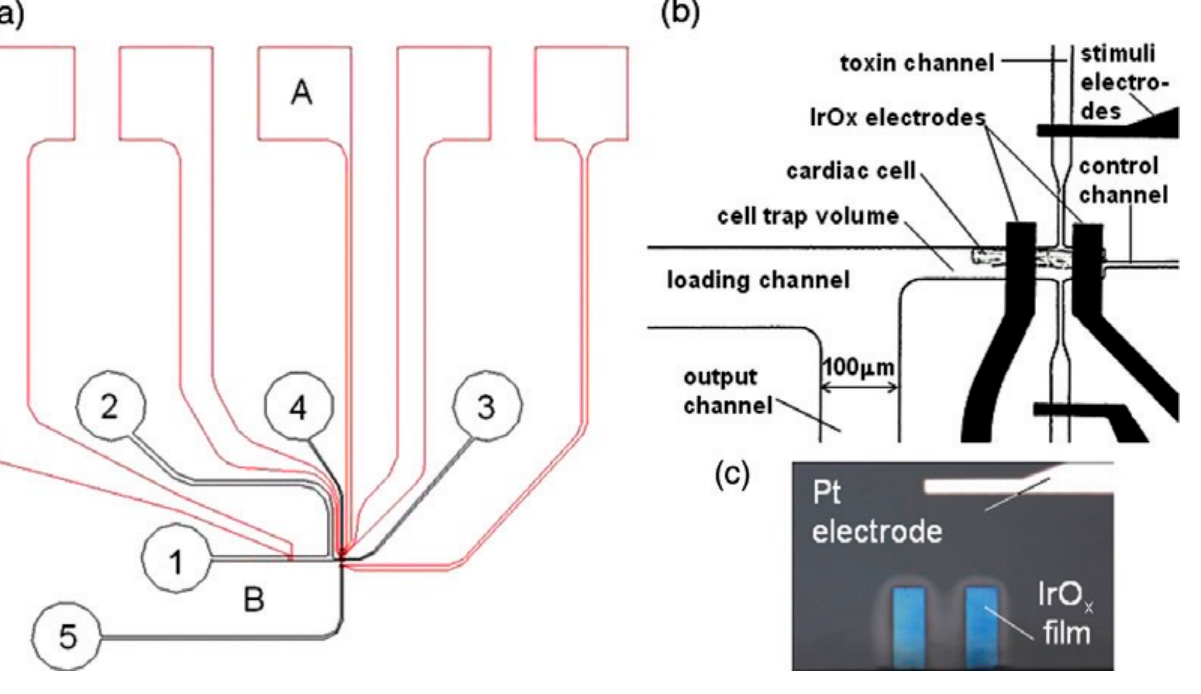
Figure 9. ( a ) Diagram of a microfluidic sensing system including microfluidic instrument and pH electrodes to trap single cardiac myocytes and to test the metabolic activity: A (red)—microelectrode array system, B (black)—microfluidic network; for 1 to 5: they are input port, output port, control port, toxin, or stimuli port, respectively. ( b ) Specific structure of pH IrOx microelectrodes, stimulation electrodes, and the cell trap with loading and waste channels. ( c ) Optical picture of the IrOx pH-sensitive microelectrodes and the Pt stimulation electrode. Reprinted with permission from Ref. [138]. (Copyright, 2019, MDPI).